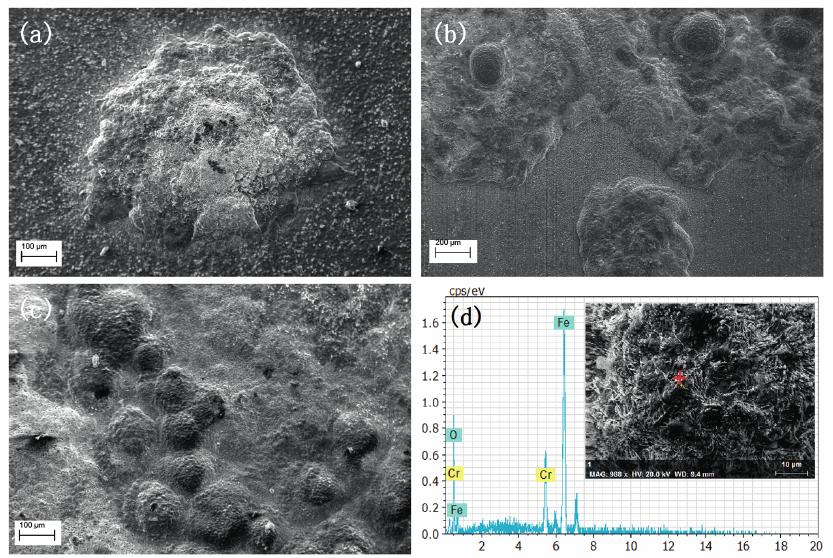
Figure 4: Surface morphology of big “ bubbles ” on the scale surfaces developed on stainless steel 441 at (b) 13.0 vol.% H 2 O, (c) 15.7 vol.% H 2 O, (d) EDS of blade-like Fe 2 O 3 grains on the surface of the bubbles.